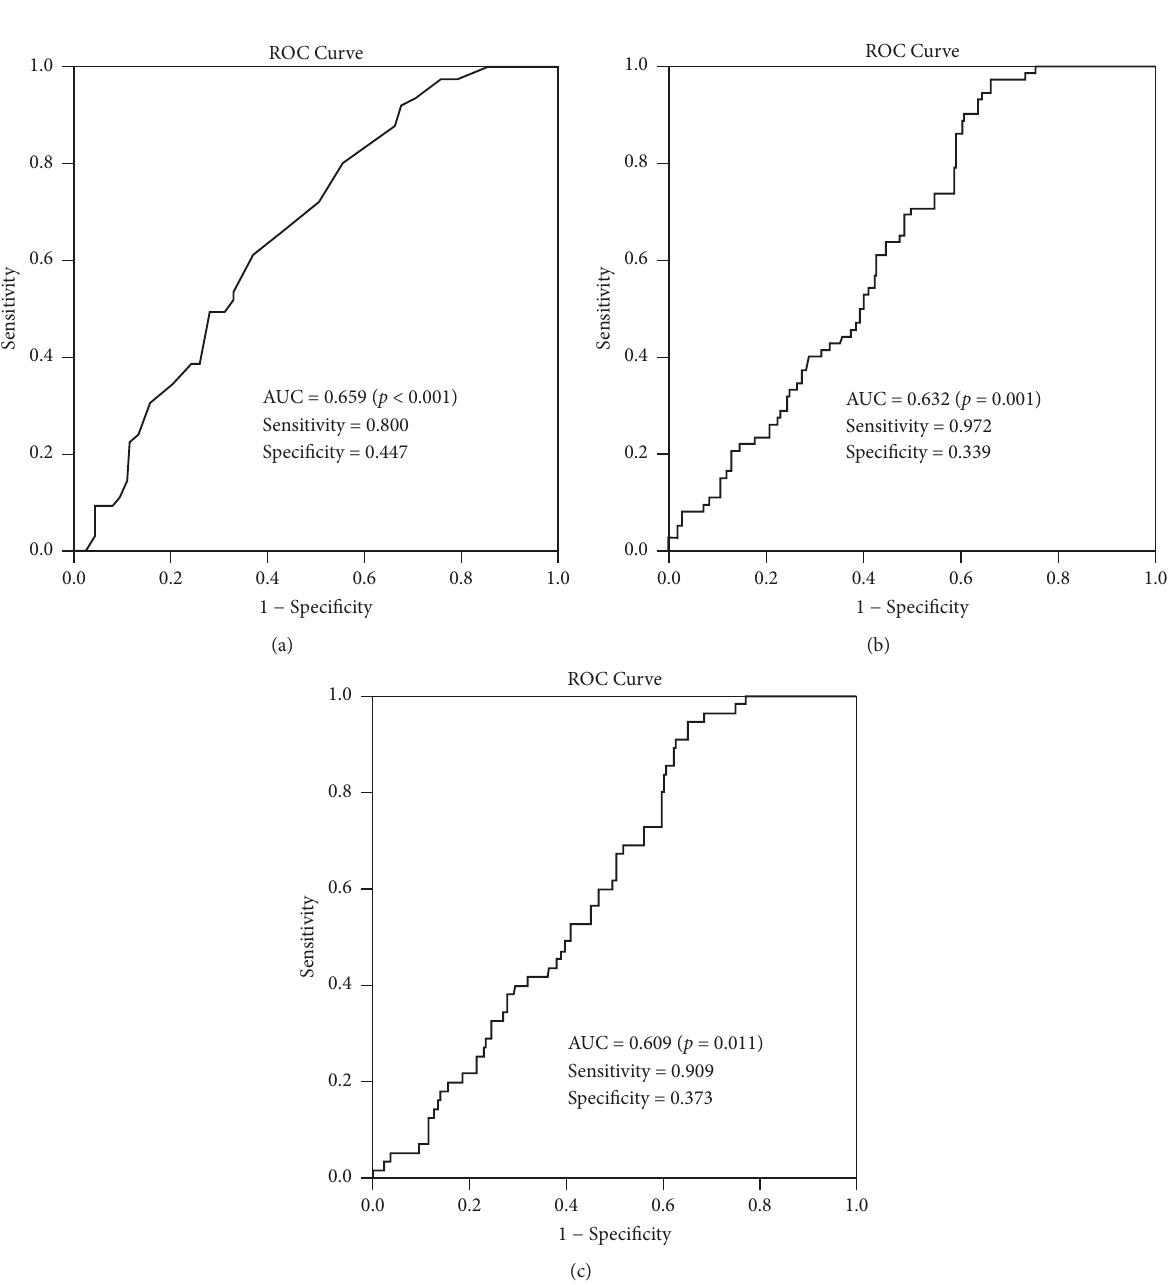
Figure 5: ROC curve and parameters of associated factors, including age to virologic relapse (a), the level of HBsAg to virologic relapse (b), and the level of HBsAg to clinical relapse